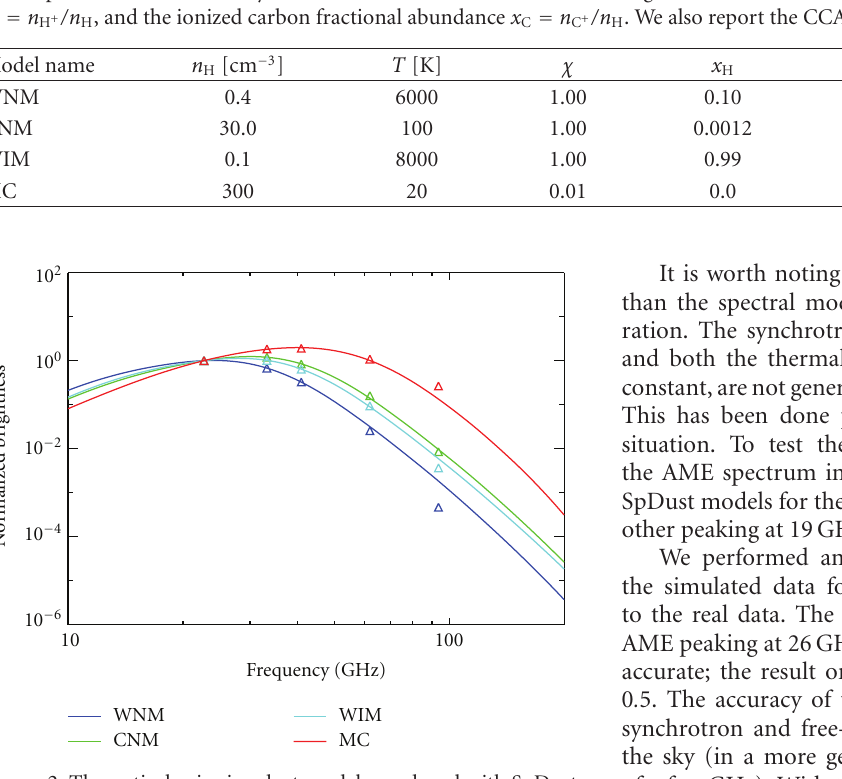
Figure 2: Theoretical spinning dust models produced with SpDust (solid lines) and fitted with CCA parametric model (triangles, same color of the model). Input SpDust parameters and best-fit parameters for the CCA model are provided in Table